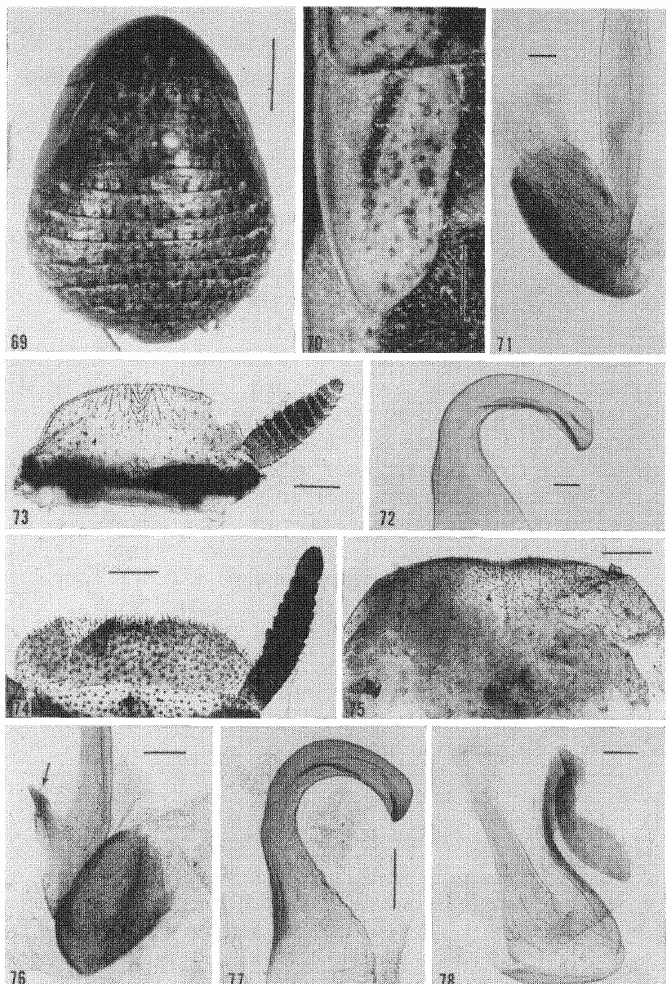
Figures 69-78. Calolamlra subgracilis and C. confusa. 69-73. C. sub- gracilis. 69-70. ? (150 MCZ), paratype, A. (without exact locality). 69. Adult. 70. Tegmen of female shown in figure 69. 71-73. (86 MCZ), holotype, Melbourne, V. 71-72. Genitalia. 73. Supra-anal plate.. 74-78. Calo- lamra confusa. (115 MCZ), holotype, A. (without exact location). 74- 75. Supra-anal plate and hypandrium. 76-78. Genitalia (arrow indicates lateral spur near base of L2vm in figure 76). Scale: Fig. 69 mm; Fig. 70 mm; Figs. 71-72 0.1 mm; Figs. 73-75 0.5 mm; Figs. 76- 78 0.2